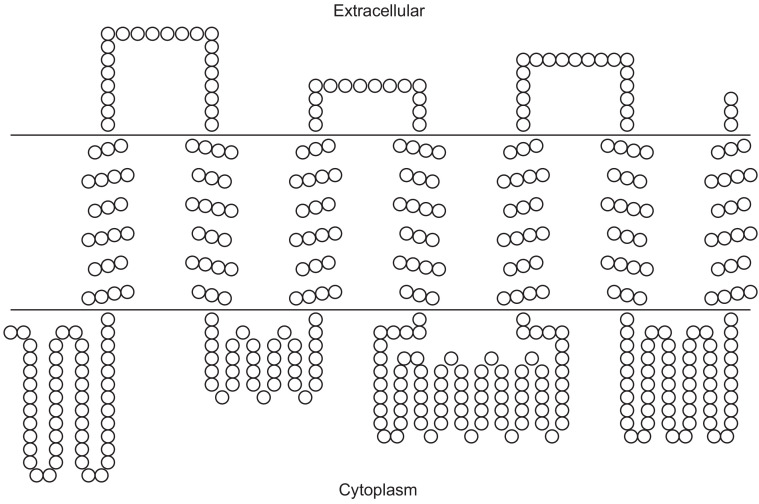
Secondary structure prediction of PxylGr34.Image was constructed using TOPO2 software (http://www.sacs.ucsf.edu/TOPO2/) based on secondary structure predicted by TOPCONS (topcons.net) models (Tsirigos et al., 2015). Only the model with a reliable seven-transmembrane structure was adopted.